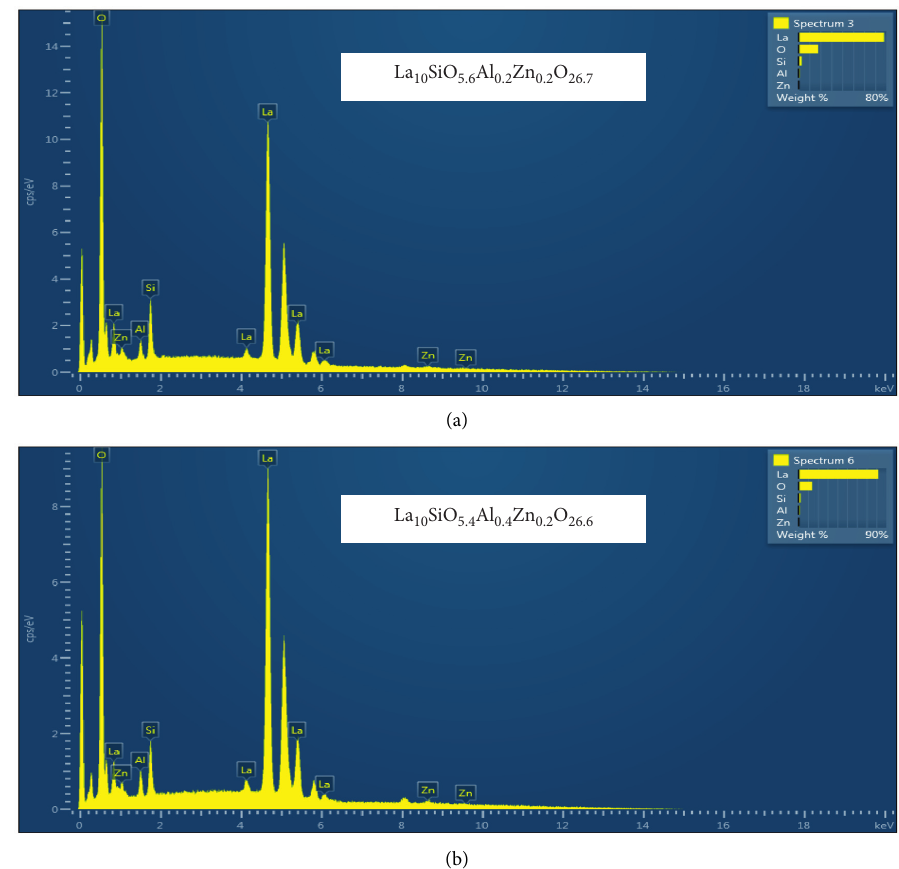
Figure 4: EDX spectra of La 10 Si 5.6 Al 0.2 Zn 0.2 O 26.7 (top) and La 10 Si 5.4 Al 0.4 Zn 0.2 O 26.6 (bottom) powders sintered at 1600